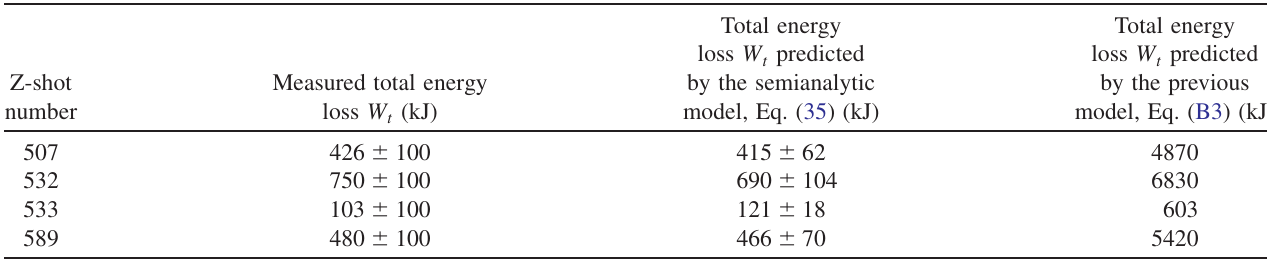
ENERGY LOSS TO CONDUCTORS . . TABLE II. Comparison of the conductor energy loss measured on Z-shots 507, 532, 533, and 589 with predictions of the semianalytic model, as expressed by Eq. (35). We also compare the measurements with predictions of a previously used conductor-loss model [Eq. (B3)]. The measurements validate Eq. (35) to zeroth order. The measurements also suggest that the previous model is significantly in error, and can predict losses that are too large by as much as an order of magnitude.